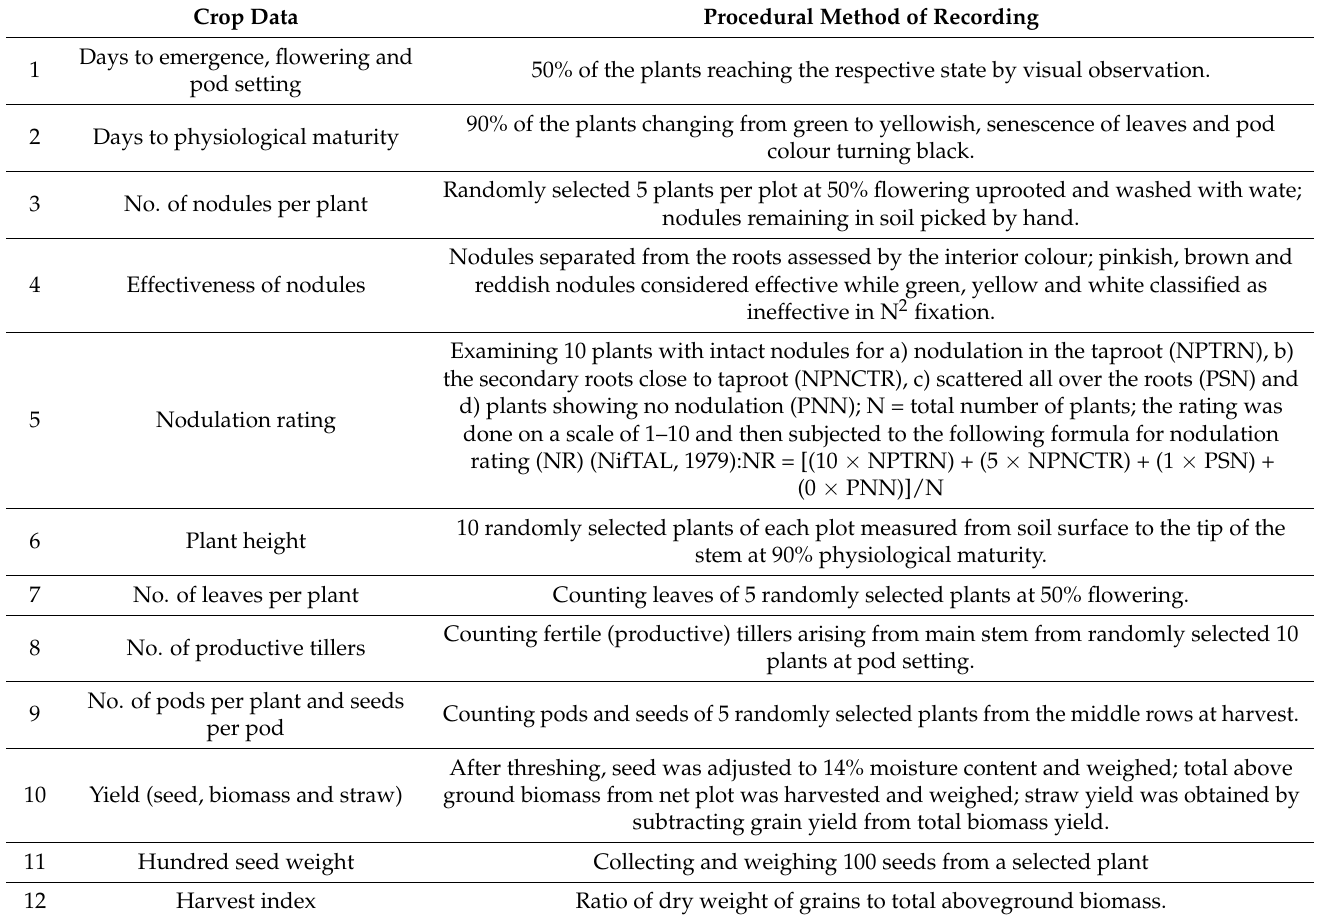
Table 3. Observations and measurements made from the